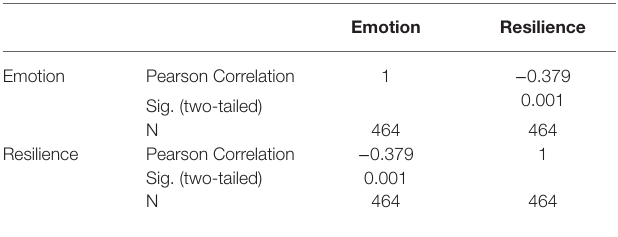
TABLE 1 | Correlations between teachers’ resilience and their